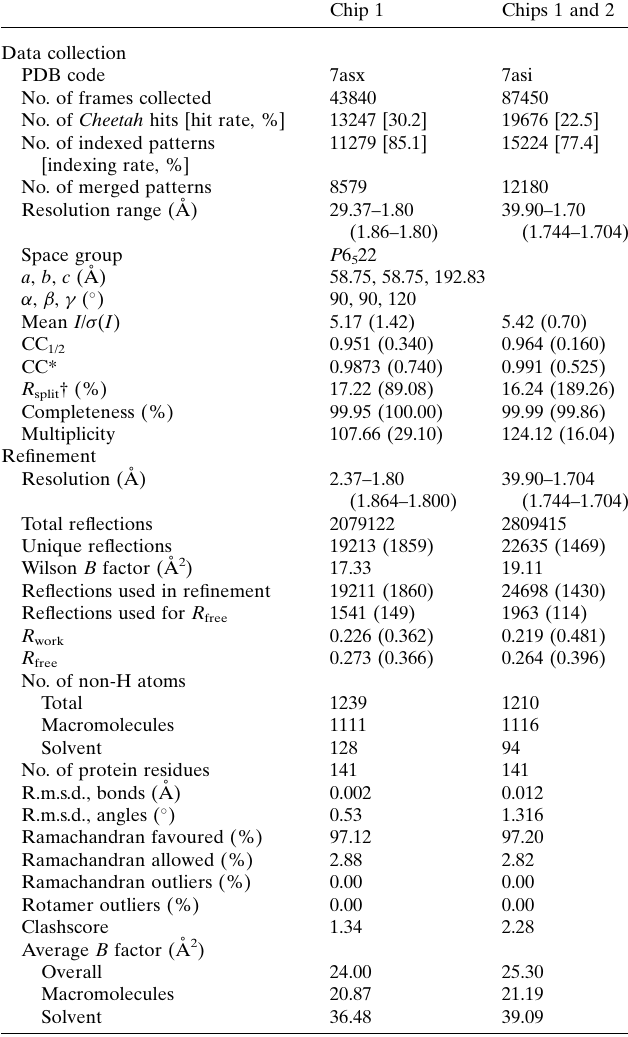
Table 1 FT-SFX data-collection and refinement statistics for N. crassa HEX-1 loaded onto Roadrunner II chips. Values in parentheses are for the highest resolution